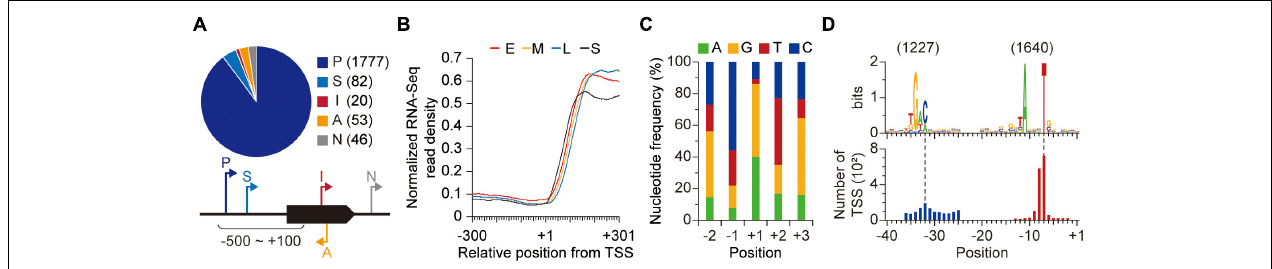
FIGURE 1 | Genome-wide identification of transcription start sites (TSSs). (A) TSSs identified from dRNA-Seq. (B) RNA-Seq read density across the identified TSSs. (C) Nucleotide frequency near the TSSs. (D) The conserved promoter sequence of S. lividans TK24. Each promoter motif was discovered